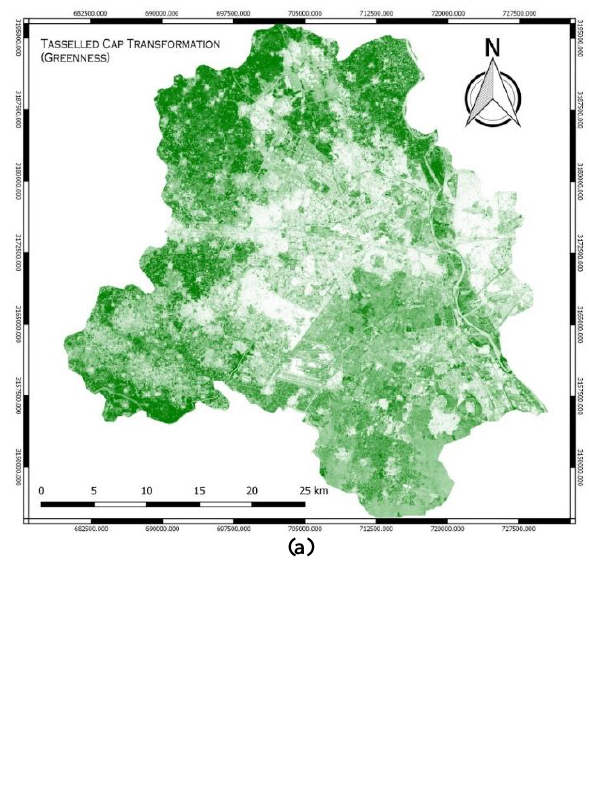
Figure 4 . (a) Regression trend line for Greenness and imperviousness value; (b) Regression trend line for NDVI and imperviousness